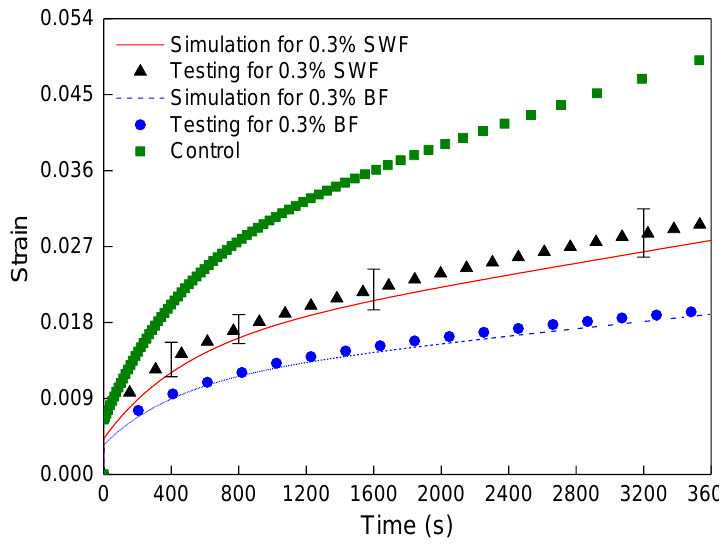
Figure 17. Flexural–tensile rheological values of the model under different fiber types.